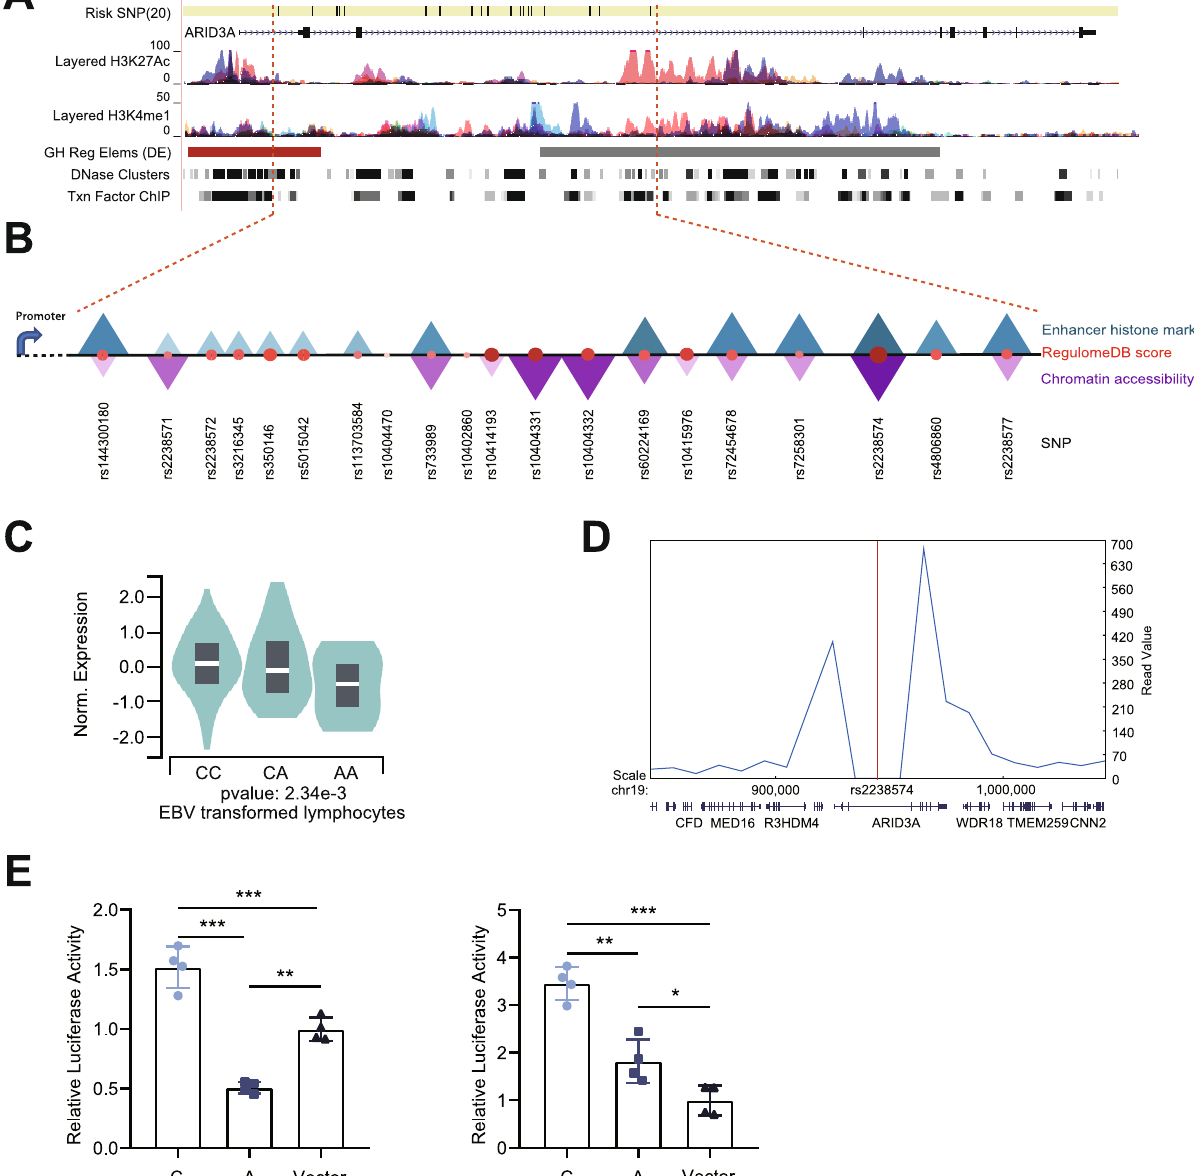
locusinK562cells.Sourcedataarederivedfrom3DGenomeBrowser. E Luciferase reporter assay in HEK293T and K562 cells transfected with pGL3 plasmids con- taining rs2238574. Luciferase signals are normalized to Renilla signals. Data are representative of three independent experiments (Mean ± SD for quadruplicates). P values are calculated using unpaired two-tailed Student ’ s t test and indicated signi fi cant if * p <0.05, ** p <0.01, or *** p